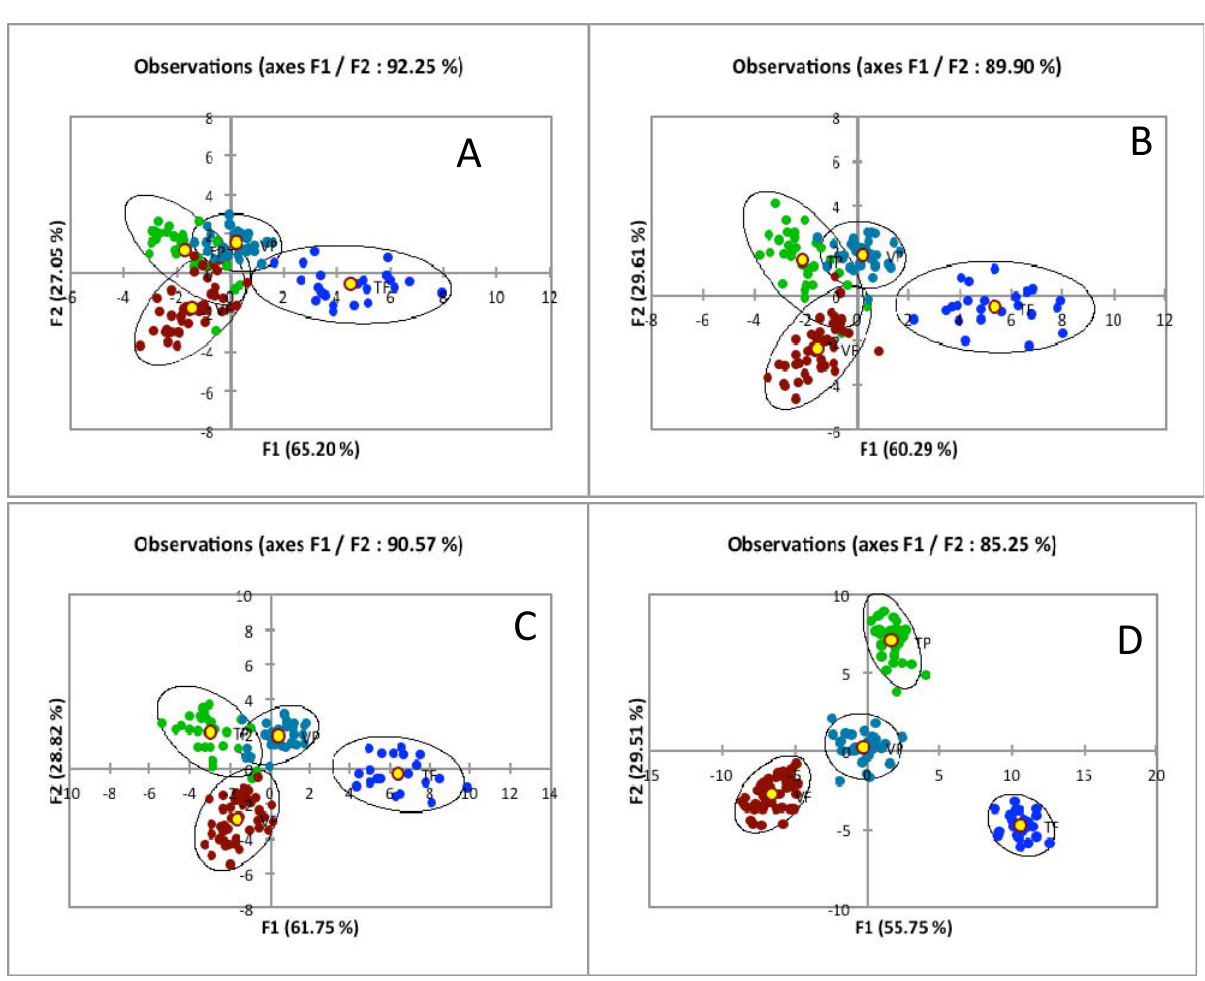
Figure 4. Discriminant Analysis of Liver Triglycerides in mice models prepared for Non-alcoholic fatty liver disease (NAFLD) treatment tests. Four different subgroups (n = 133) were identified with 2 genetic backgrounds (blue/green and dark blue/black symbols) as a function of the enriched or depleted lipid diets (green/dark blue and blue/black symbols). Triglyceride molecular species in the liver lipid extract were assayed by LCMS2. The multivariate analysis was conducted taking into account an increasing number of molecular species A = 11, B = 21, C = 31 and D = 51. In each subgroup the centroid (yellow dot) and confidence ellipses are calculated and positioned to maximize the discrimination of subgroups in the factor plan F1/F2. It is apparent that the within-class dispersion is decreased but the separation (between-classes covariance) is increased between centroid subgroups as a function of the number of molecular species which is taken into account for calculation. However the confusion matrix reveals that the rate of erroneous assignment to subgroups of test samples is sharply rising with the number of molecular species taken into account in the calculation (A, 0%; B, 0%; C, 77%; D, 83%). See Section